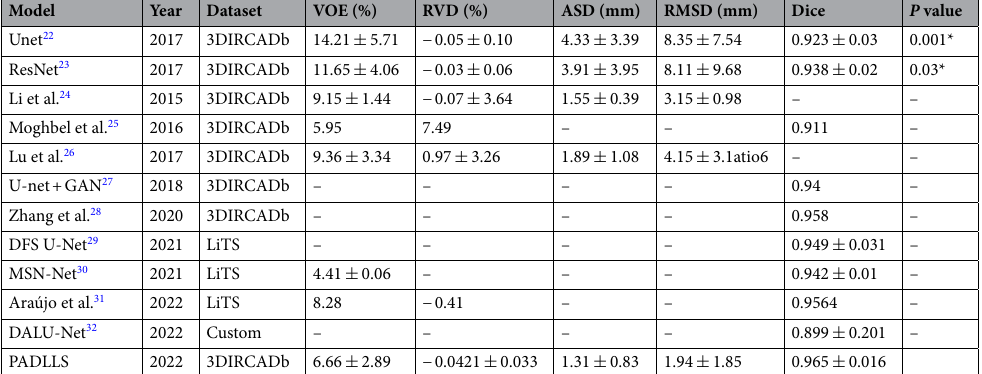
Table 4. Comparison of other liver segmentation models on 3DIRCADb challenge. An asterisk indicates a statistically significant difference in Dice score between our pipeline and another model ( p < 0.05). A dash indicates inability to assess for statistical significance due to the absence of reported Dice score and standard